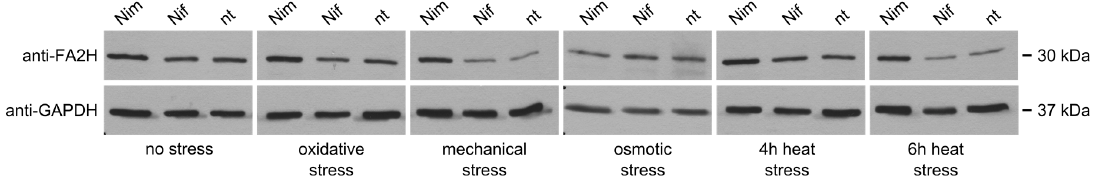
Figure 6. FA2H protein levels in undifferentiated Neuro2a cells. 20 μ g total protein was on loaded per sample on a 12% SDS-PAA gel. One representative out of at least three biologically independent experiments is displayed. Nim = nimodipine pre-treatment (20 μ M); Nif = nifedipine pre-treatment (20 μ M) nt = no drug pre-treatment; anti-FA2H = rabbit anti-FA2H antibody (1:1000); anti-GAPDH = mouse anti-GAPDH antibody (1:5000; loading control).